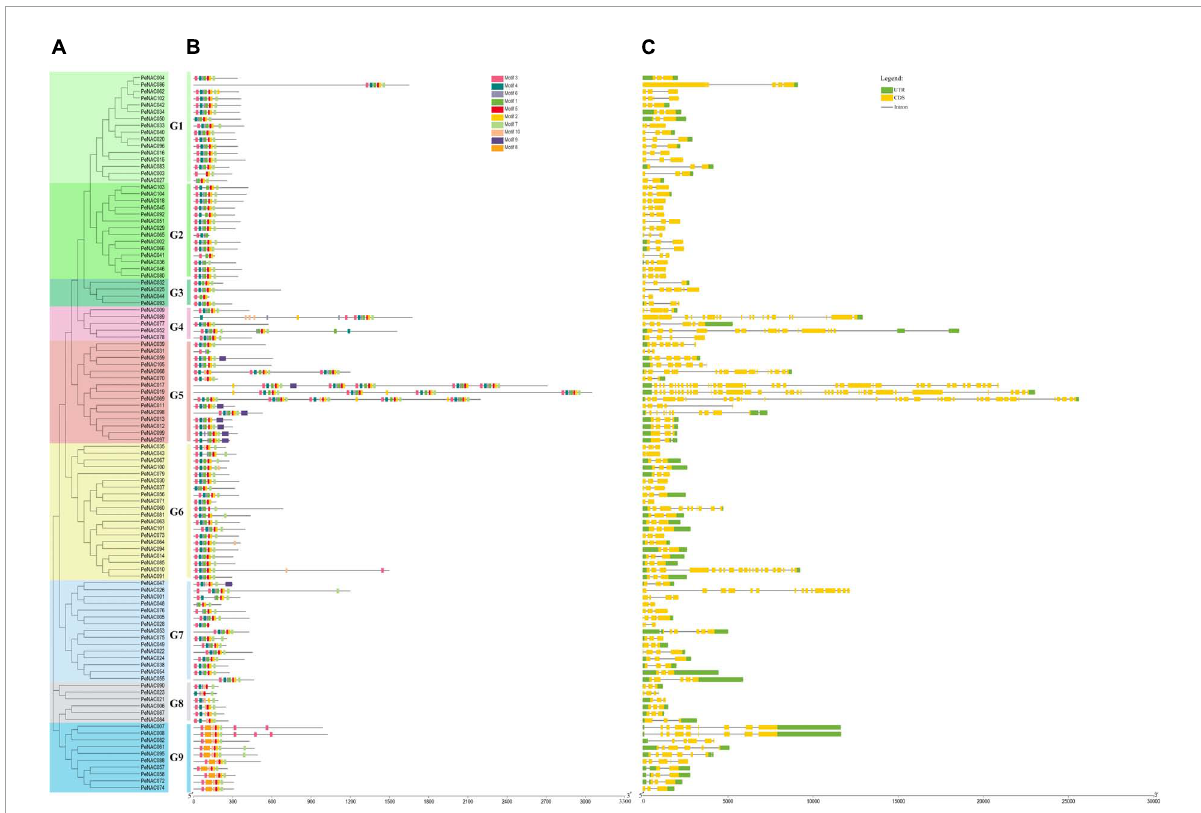
FIGURE2 The unrooted phylogenetic tree, conserved motifs, and gene structure of PeNAC genes. (A) The neighbor-joining tree on the left comprised 105 PeNAC proteins, different colors represented different groups. (B) Conserved motifs were represented via boxes and different colors represent different motifs. (C) PeNAC genes structures, yellow color indicates the exons, the green color shows the untranslated 5 (cid:48) and 3 (cid:48) -regions, and gray color indicates the